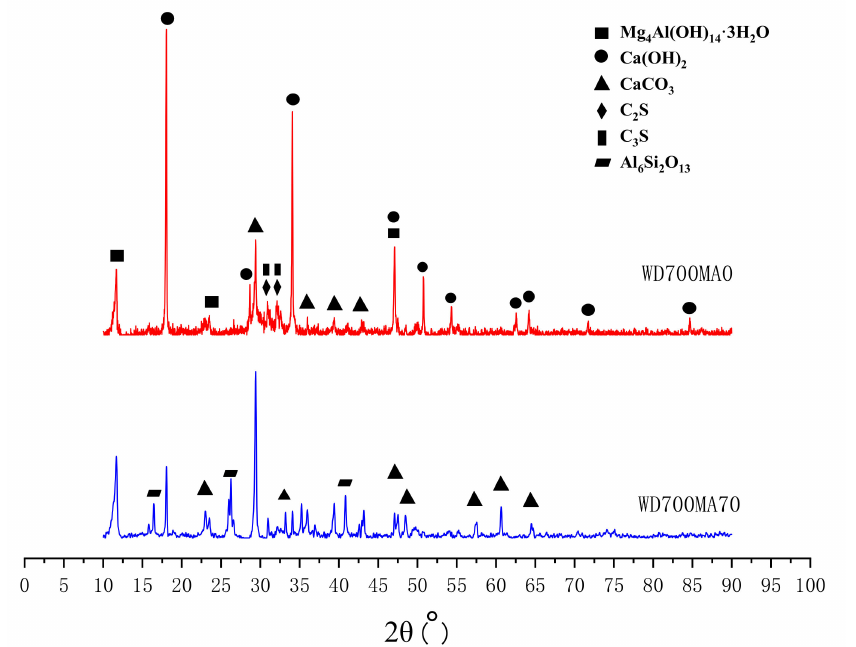
Figure 15. XRD patterns of foamed concrete with different LM–FA